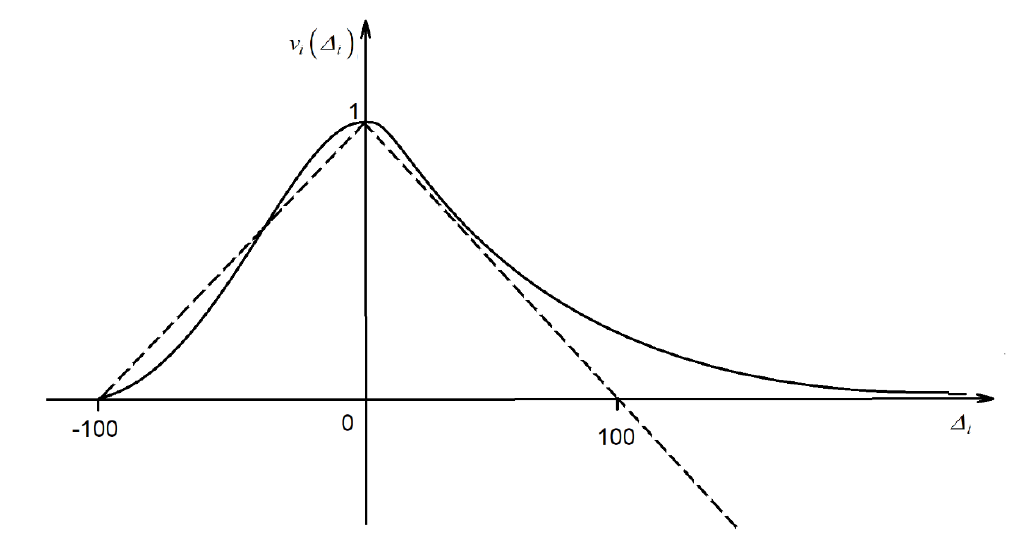
Figure 6: Example of the value functions 